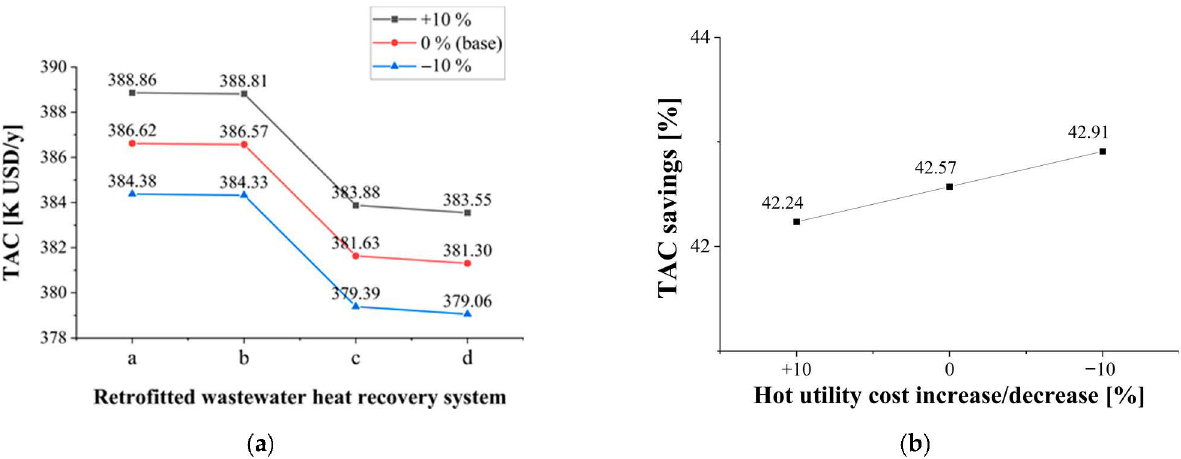
Figure 9. Sensitivity analysis of C elec on TAC. ( a ) TAC of each retrofitted wastewater heat recovery system as C elec changes, ( b ) maximum TAC savings as C elec